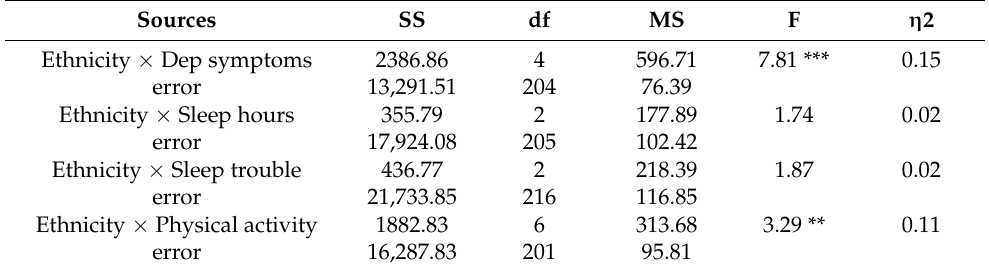
Table 3. ANCOVA examining interaction effects of ethnicity and main independent variables on SMI.